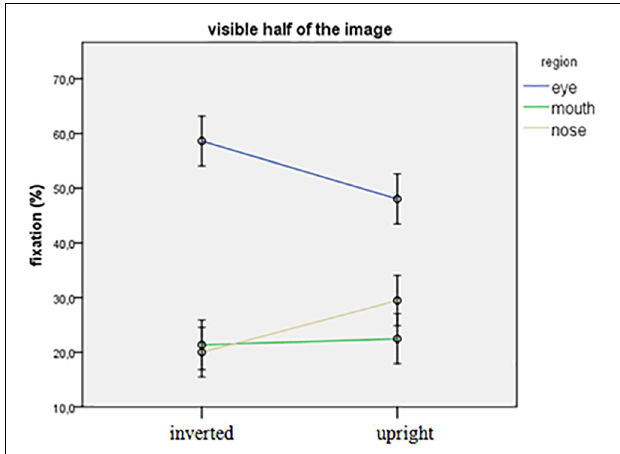
FIGURE 2 | Relative fixation values targeted at the three regions on the visible half of the stimulus.